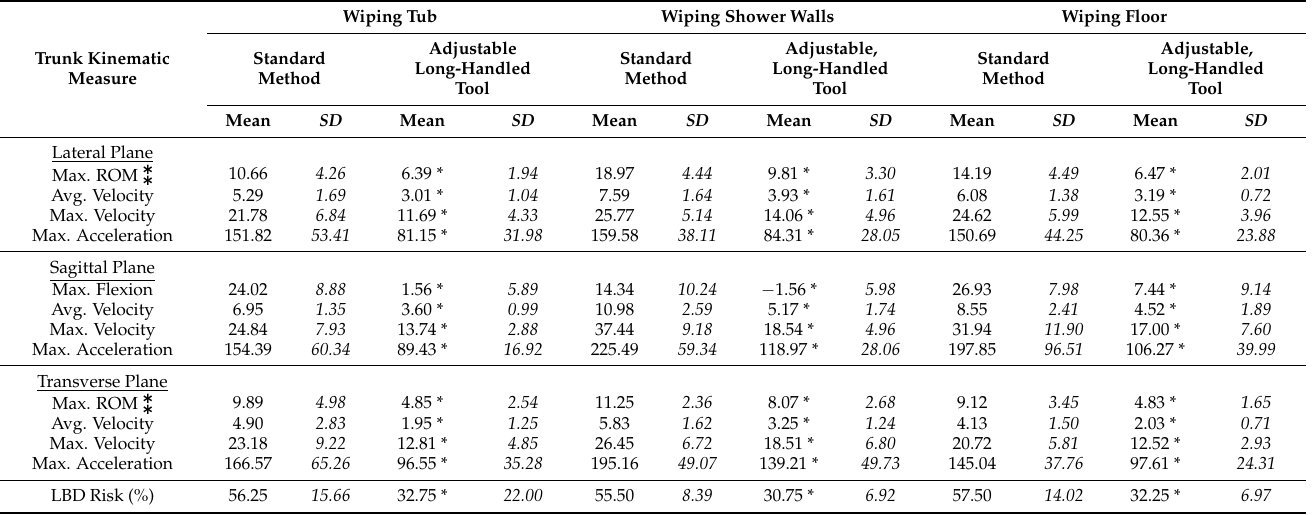
Table 1. Means and standard deviations (SD) for trunk kinematic and LBD Risk measures, for three hotel bathroom-cleaning tasks. Range of motion values are in degrees, velocities are in deg/s, and accelerations in deg/s 2 .